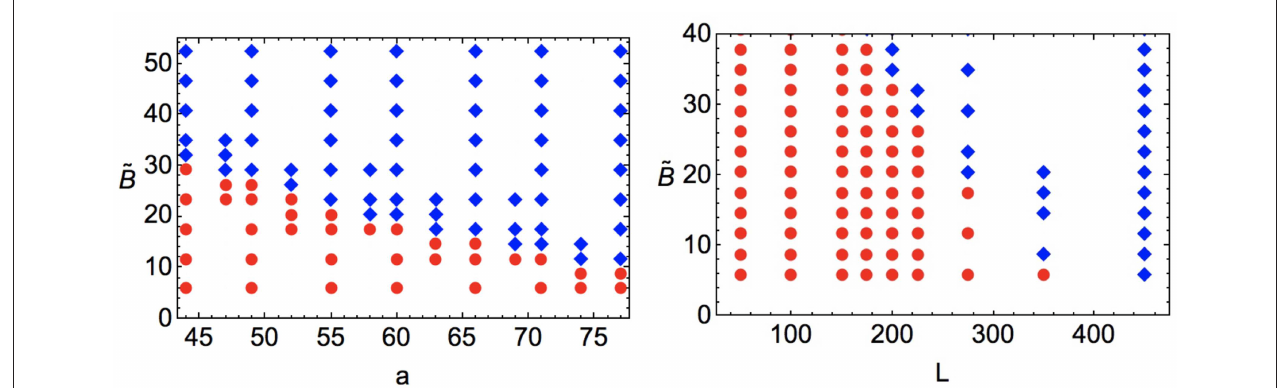
FIGURE 5 | Stability of dipolar defects around a spherical colloidal inclusion at fixed S 0 colloid size a , and linear system size L , with a and L in units of the lattice spacing. Regions of parameter space with (meta-)stable dipolar configurations are shown with blue diamonds, stable quadrupolar configurations are shown with red circles. (Left) For fixed lattice size of N density constant ˜ B and the colloidal radius a . (Right) For fixed ratio of colloidal radius to linear system size, a for the larger values of a , one can see dependence of hedgehog meta-stability on L , indicating the importance of far-field distortions and boundary conditions (here,